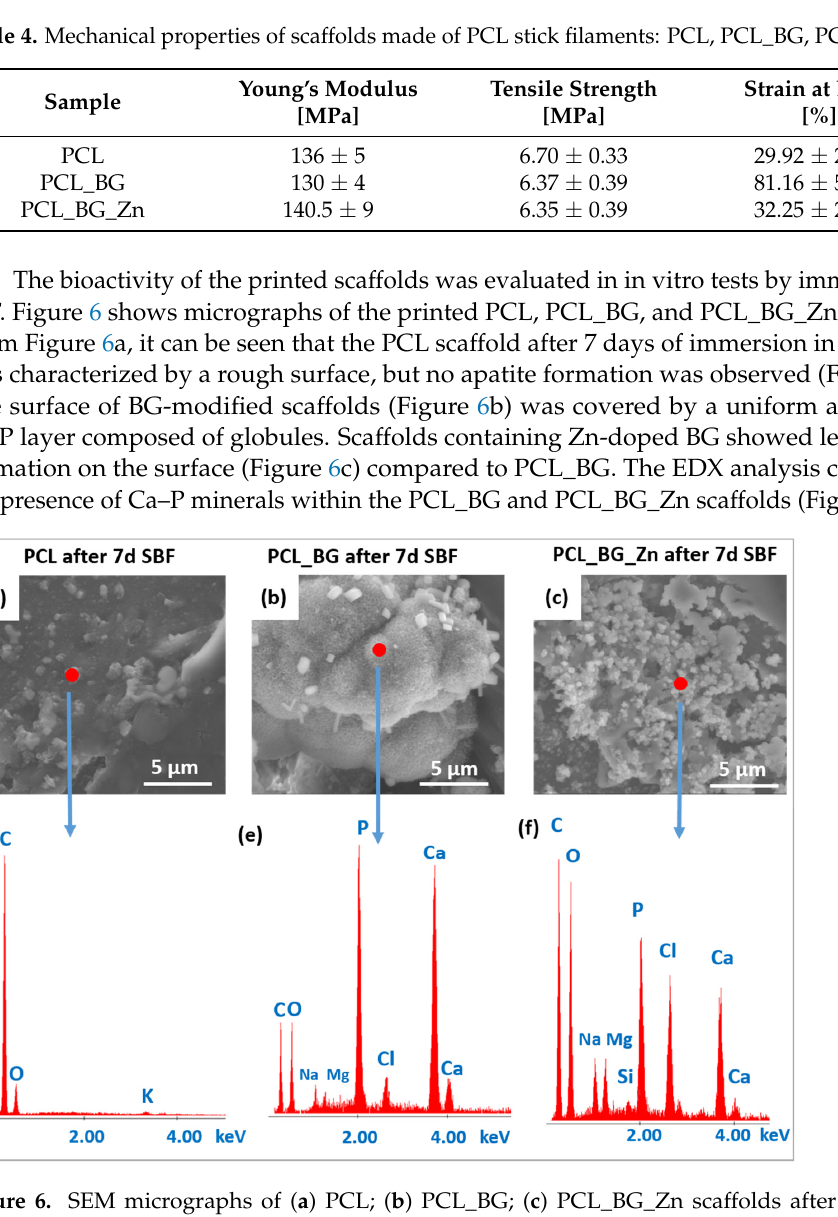
Table 4. Mechanical properties of scaffolds made of PCL stick filaments: PCL, PCL_BG, PCL_BG_Zn.